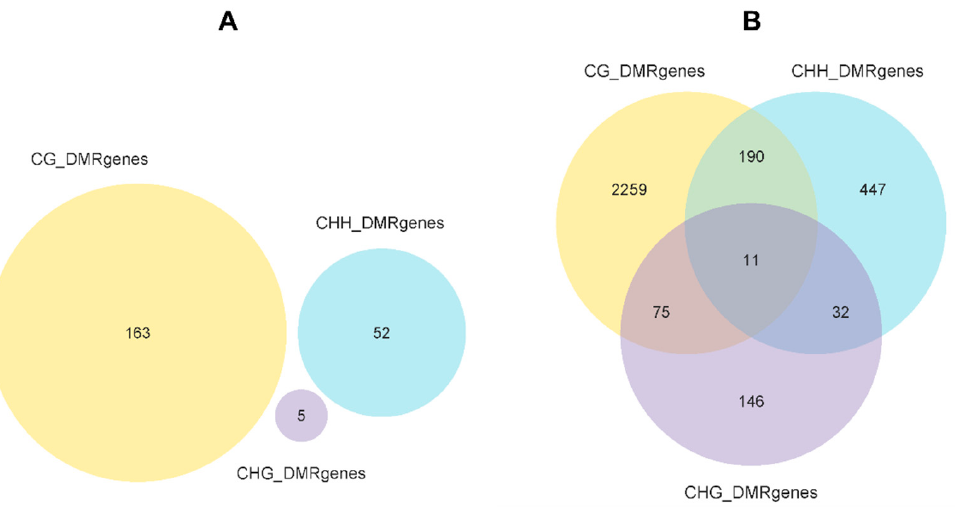
Figure 4. Venn analysis of cold vs. control DMGs under CG, CHG, and CHH contexts in the promoter and gene body region of the H. longicornis adults. ( A ). Venn analysis of DMGs in the promoter region. ( B ). Venn diagrams of DMGs in the gene body region.